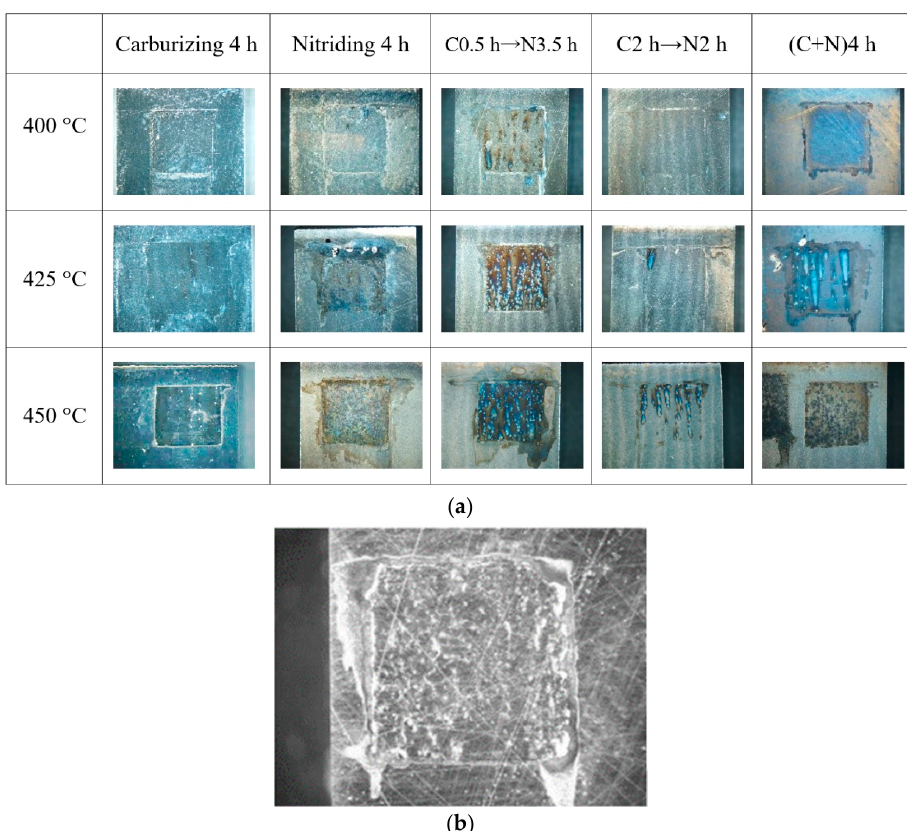
Figure 13. Surface morphology after anodic polarization measurements of ( a ) the S-phase layers on cold-sprayed AISI 316L coatings subjected to various low-temperature plasma treatments at different temperatures and ( b ) as-sprayed AISI 316L coating.